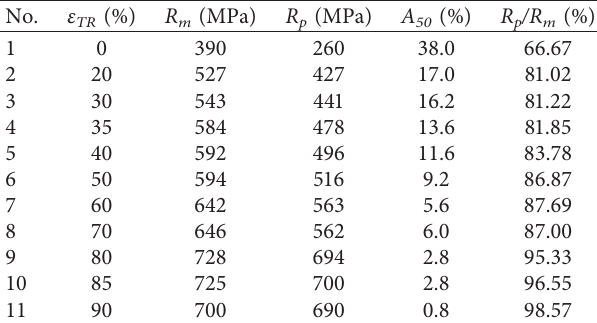
Table 2: Mechanical properties of the cold-rolled